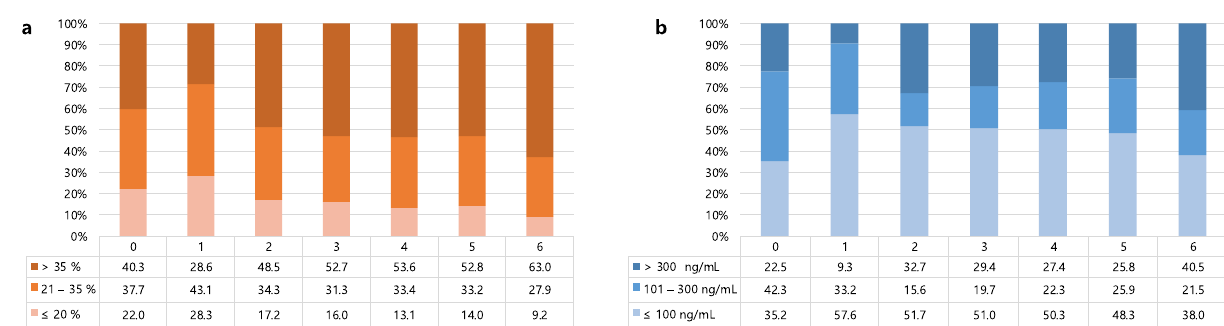
Figure 1. Temporal changes of hemoglobin and iron status. ( A ) Hemoglobin, ( B ) transferrin saturation, ( C ) Ferritin.